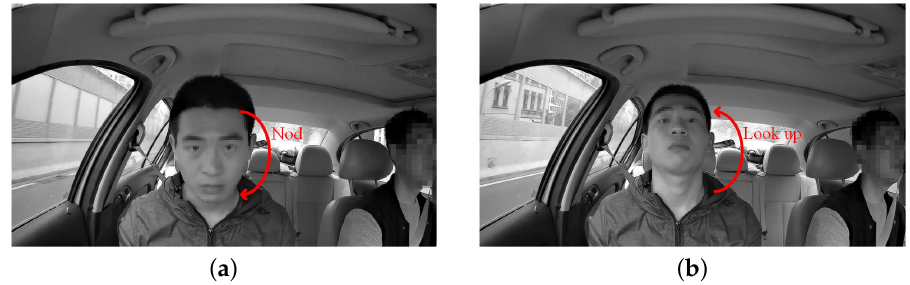
Figure 26. Facial images captured: ( a ) nod; ( b ) look up.